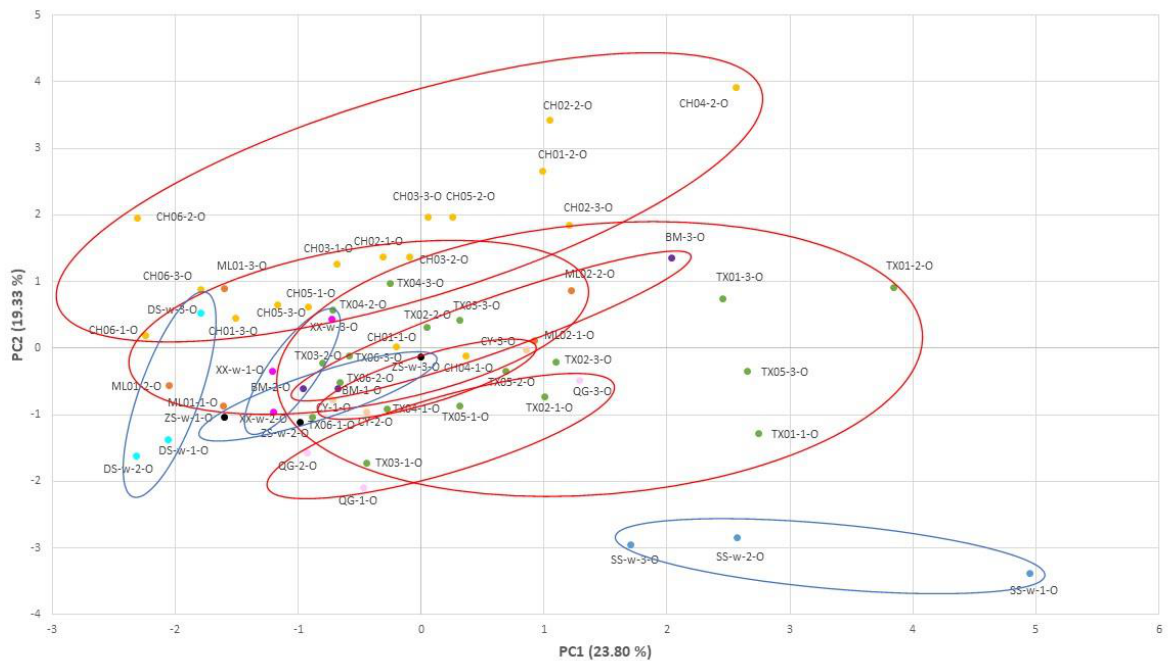
Figure 7. Principal component analysis (PCA) in the outer site of the shells: PCA plotted against the PC1 vs. PC2 axes. Different color of points in the figure means different locations.